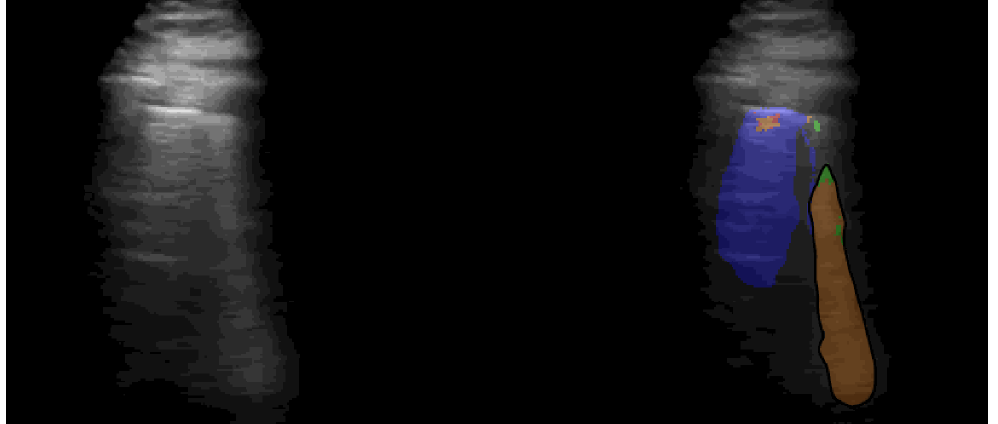
Figure A1. Example snapshot from lung segmentation of COVID-19 patient. Left side shows the raw US recording and the right side shows the segmentation method from [57] highlighting the B-line. The images shown on the right were used as input for the VGG-Segment model. Blue, orange and red correspond to signs of healthy, moderate and heavily COVID-19 infected lungs.